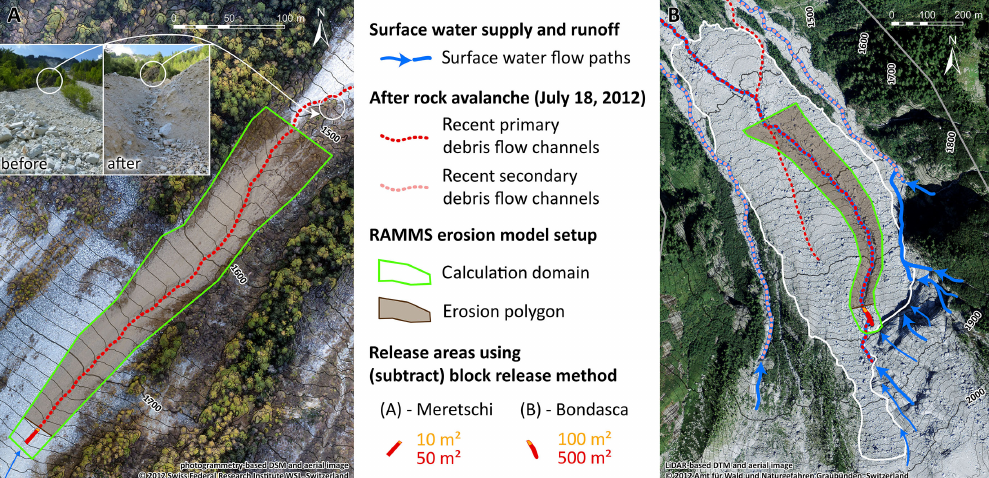
Figure 4. Erosion model configuration for the model simulations showing the initial block release areas in the Meretschibach catch- ment (a) and the Bondasca catchment, Switzerland (b) . The hillslope is erodible within the brown-shaded